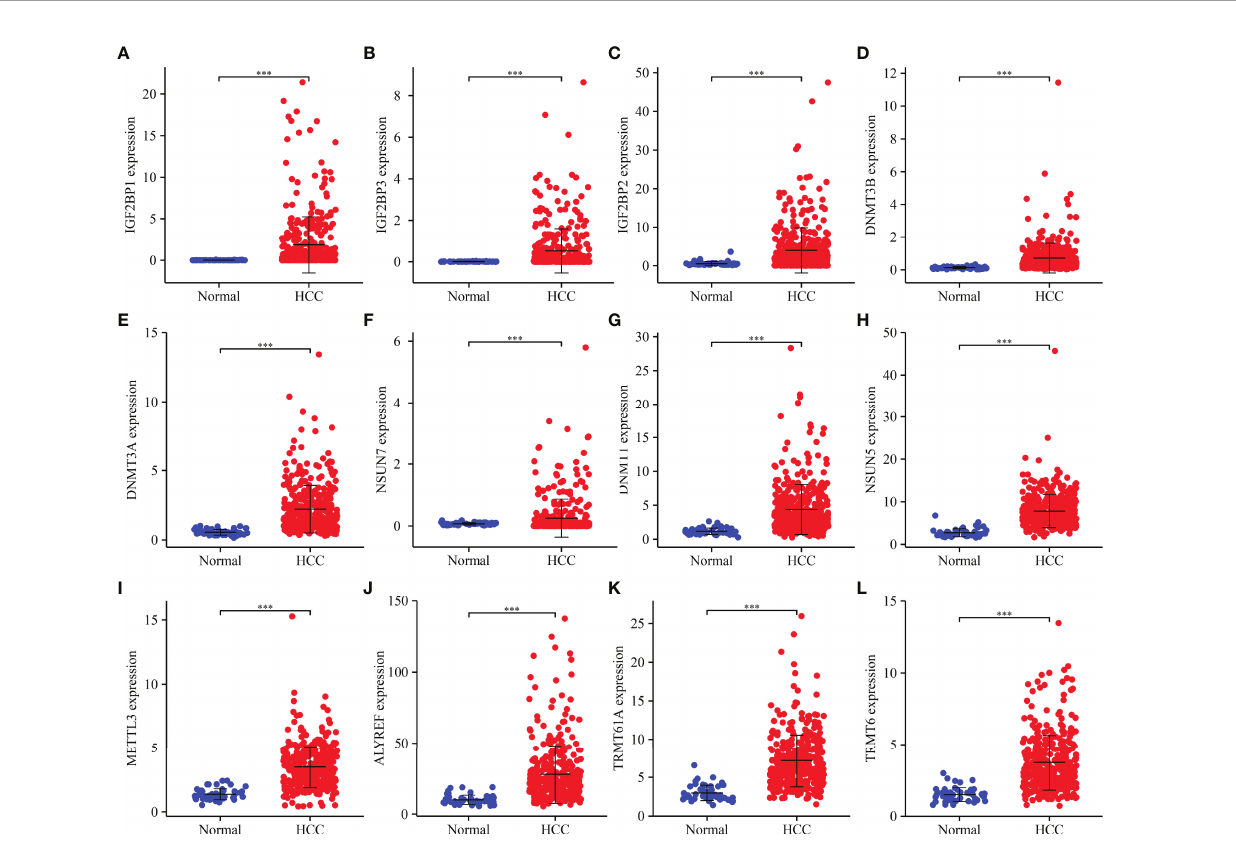
FIGURE 1 | m6A/m1A/m5C regulated DEGs in HCC tissues as determined based on fold change. (A) IGF2BP1; (B) IGF2BP3; (C) IGF2BP2; (D) DNMT3B; (E) DNMT3A; (F) NSUN7; (G) DNMT1; (H) NSUN5; (I) METTL3; (J) ALYREF; (K) TRMT61A; (L) TRMT6. DEGs, differentially expressed genes; HCC, hepatocellular carcinoma; ***P <